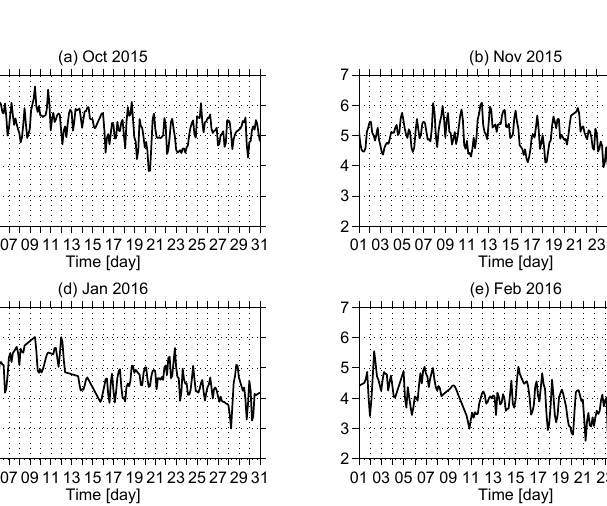
Figure 2. Monthly time series of MIAWARA H 2 O (ppm) averaged between 0.02 and 0 . 1hPa for winter 2014/2015.